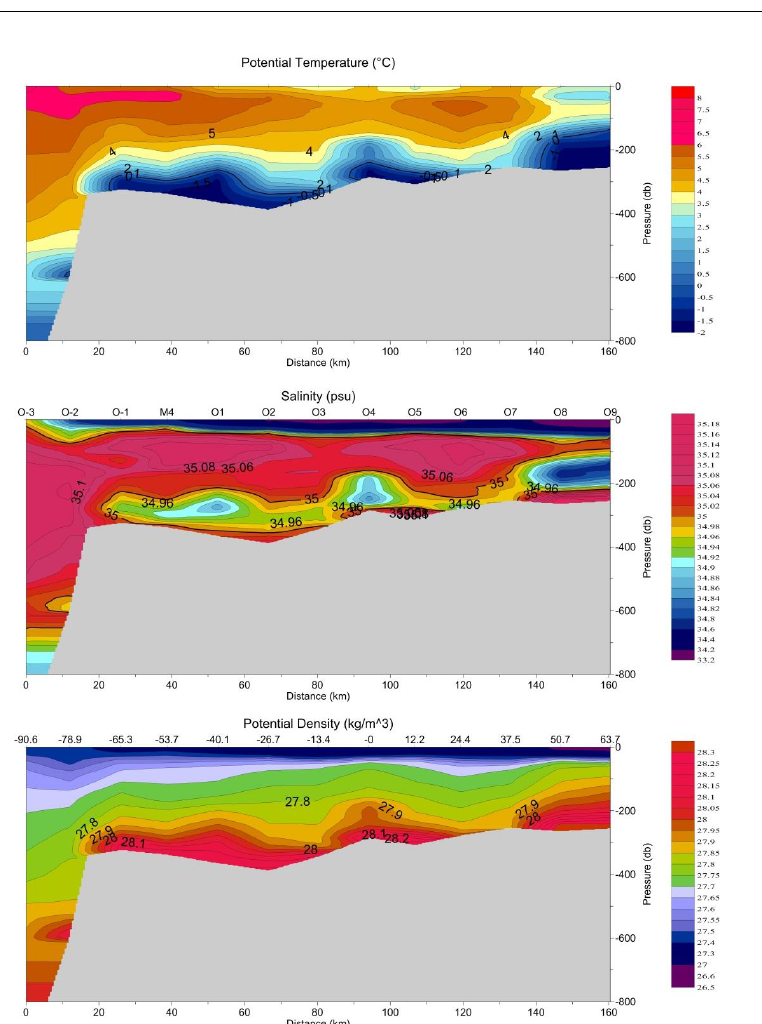
Figure 14. Inflow of the AW in the upper layer and brines migrating along the Storfjordrenna near the bottom. (a) Temperature, (b) salinity, and (c) potential density. Section “O”, R/V Oceania , summer 2000.